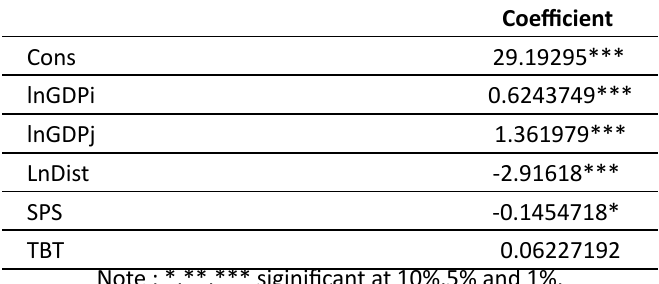
Tabel 1: Random Effect Model Estimation